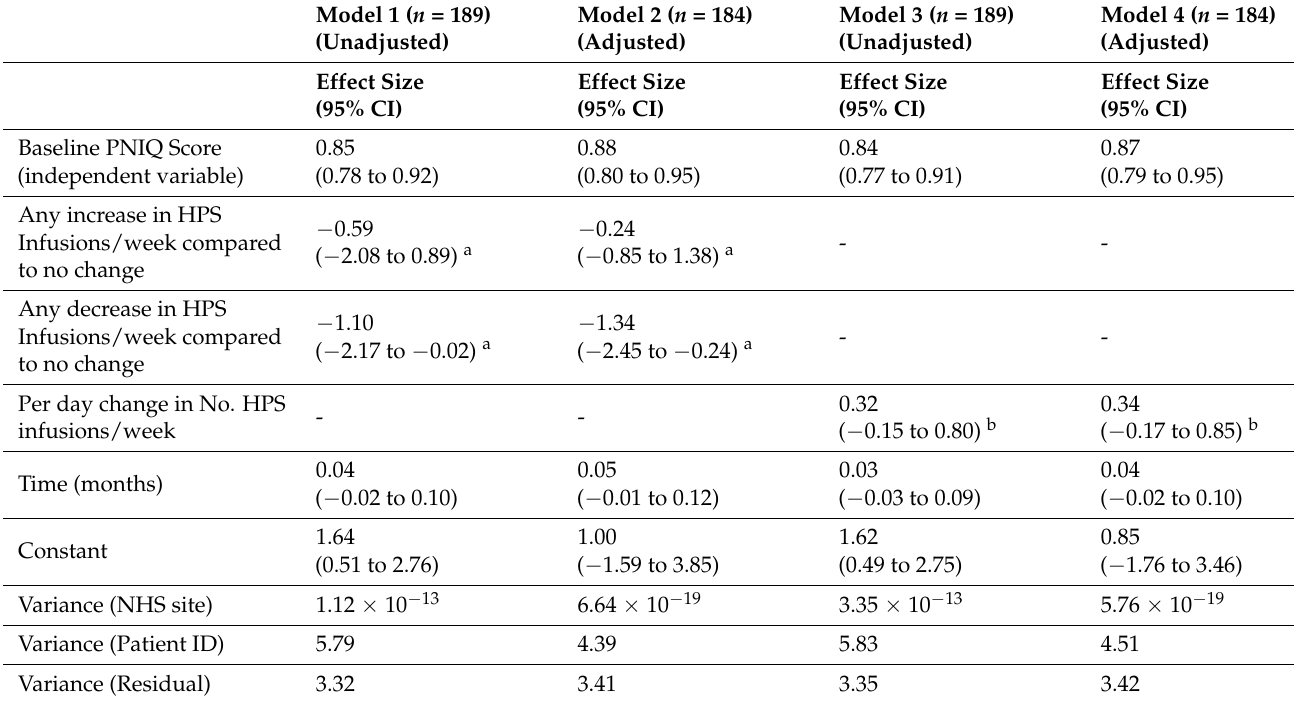
Table 3. Multi-level mixed regression analysis to show the impact of change over time in the number of home parenteral infusions per week on PNIQ score (Quality of